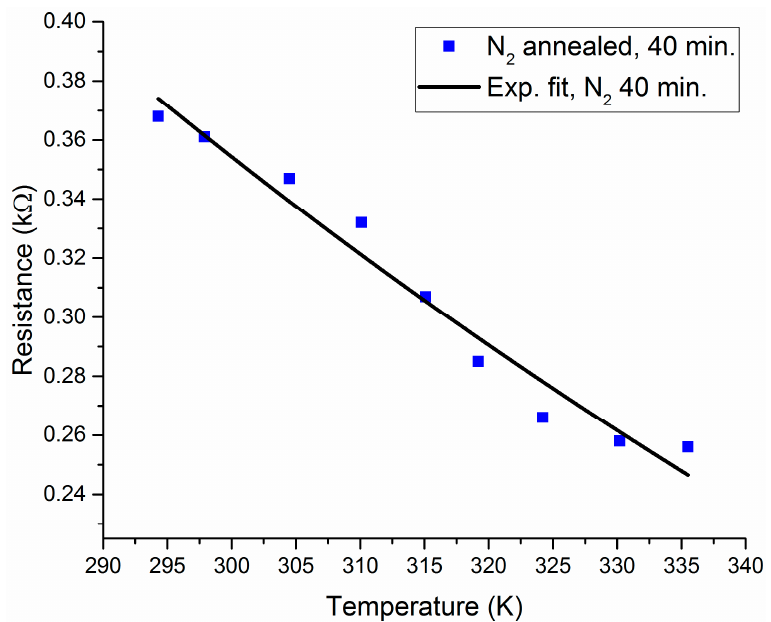
Figure 4. Measured resistance versus temperature for the resistive thermometers annealed in N 2 for 40 min.